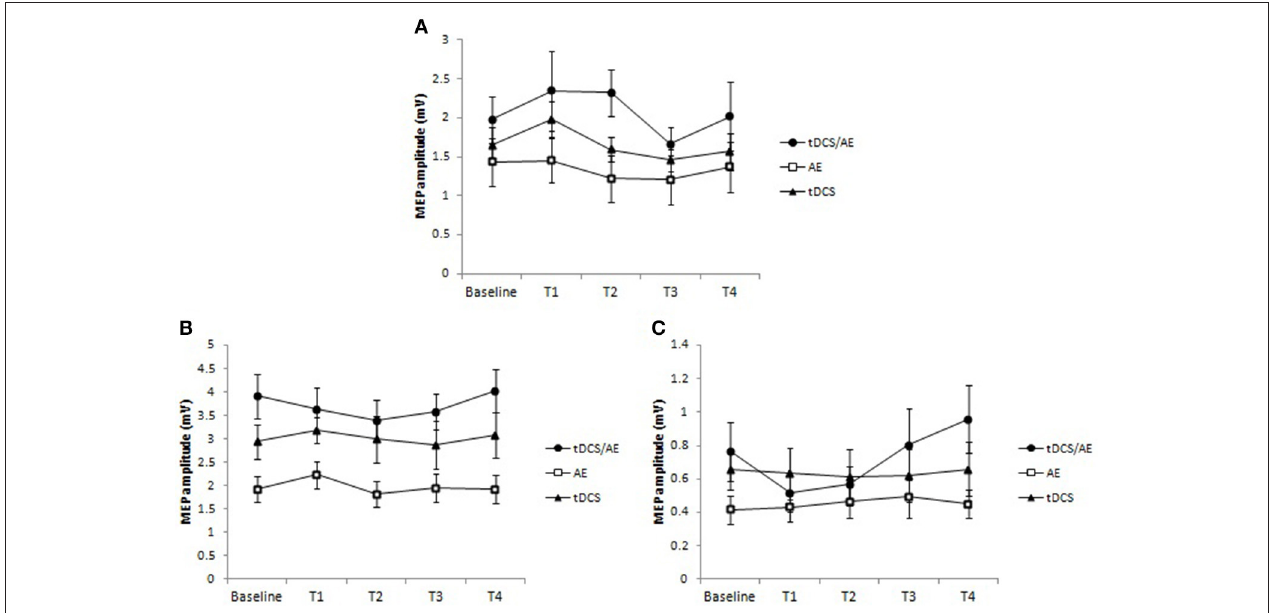
FIGURE 7 | Data for cortical excitability. (A) Data for motor evoked potential (MEP). There was an increased excitability in the tDCS/AE group until the end of the intervention, not being maintained after the period of follow-up. For tDCS group there was an increase in cortical excitability after just 1 week period of intervention that occurred with active stimulation. The EA group showed a slight decrease in MEP after the intervention. (B) Intracortical facilitation. There was a slight decrease in intracortical facilitation, represented by decreased amplitude of MEP’s only in group tDCS/AE. (C) Intracortical inhibition. There was an increase in intracortical inhibition during the protocol period for tDCS/AE group, and in the follow-up periods an increase above the baseline. No statistically significant findings were observed. Data shown as mean and standard error.